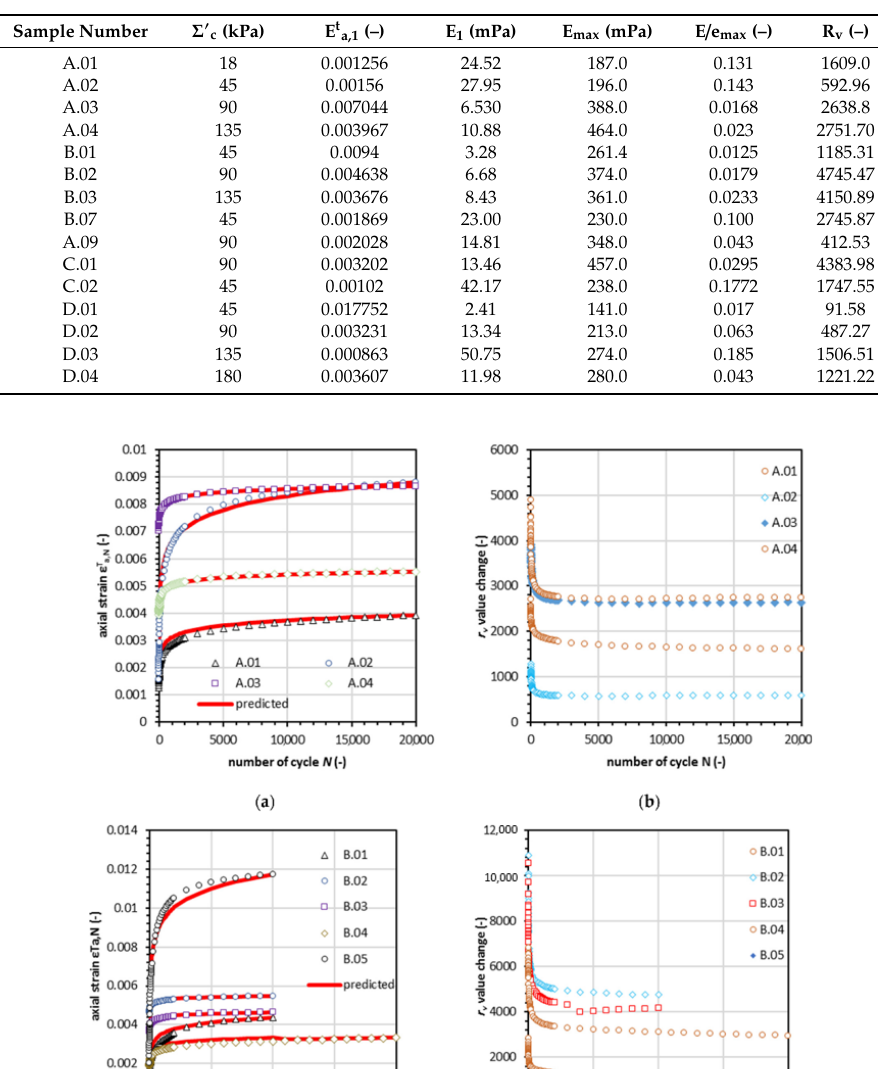
Table A1. Test data axial strain analysis.